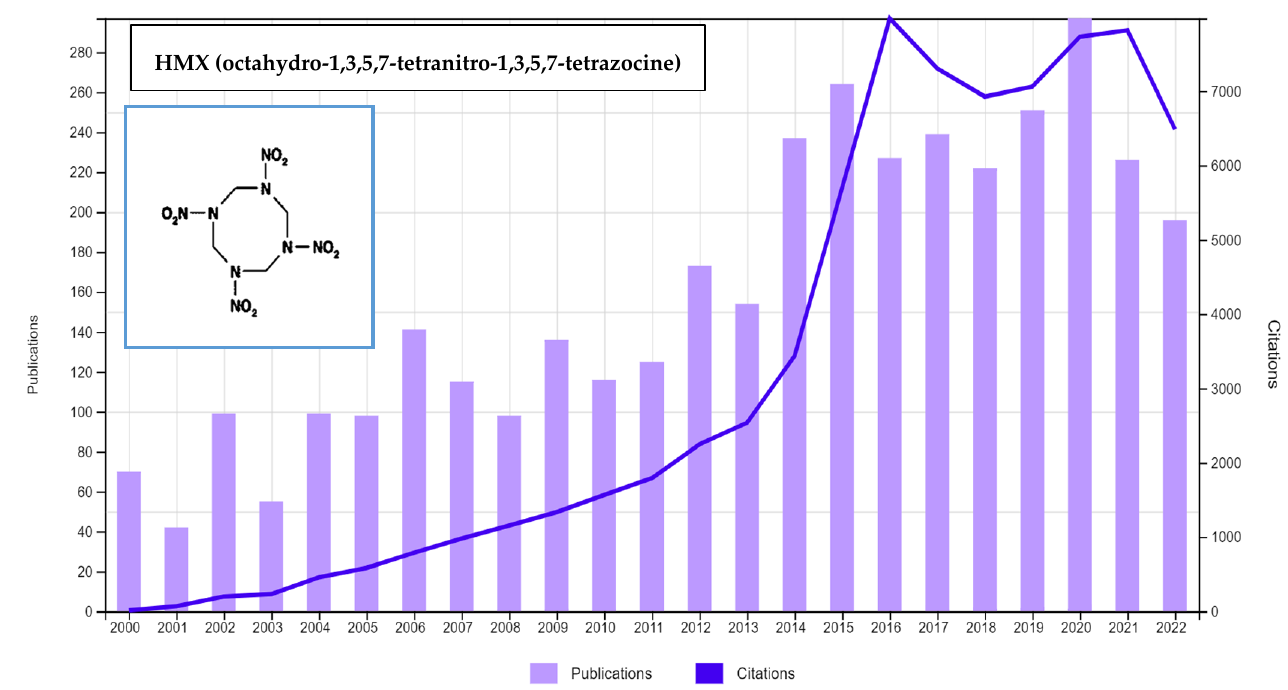
Figure 1. The trend of HMX-related investigations from 2000 to 2022 (based on https://www.webofscience.com/ accessed on 22 November 2022, keywords-HMX).